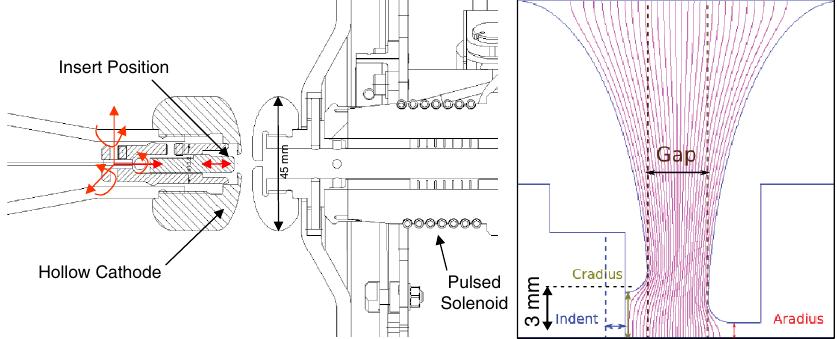
FIG. 2. Left: Cross section of the diode assembly with the hollow cathode geometry. Right: Zoom on the hollow cathode geometry showing the equipotential